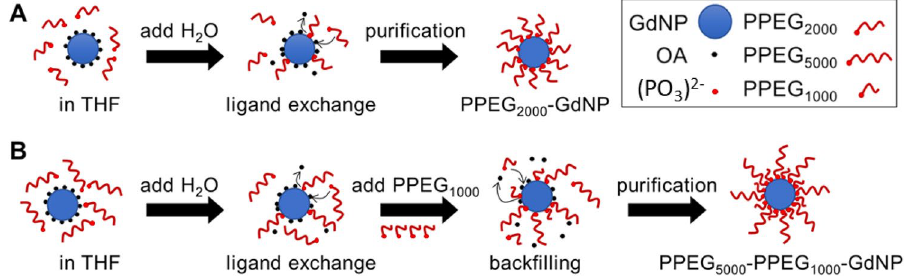
Figure 1. The synthesis of ( A ) PPEG 2000 -GdNP and ( B ) PPEG 5000 -PPEG 1000 -GdNP. OA is displaced by PPEG through ligand exchange, and the solution is purified by dialysis and vacuum sterile filtration to eliminate OA and excess